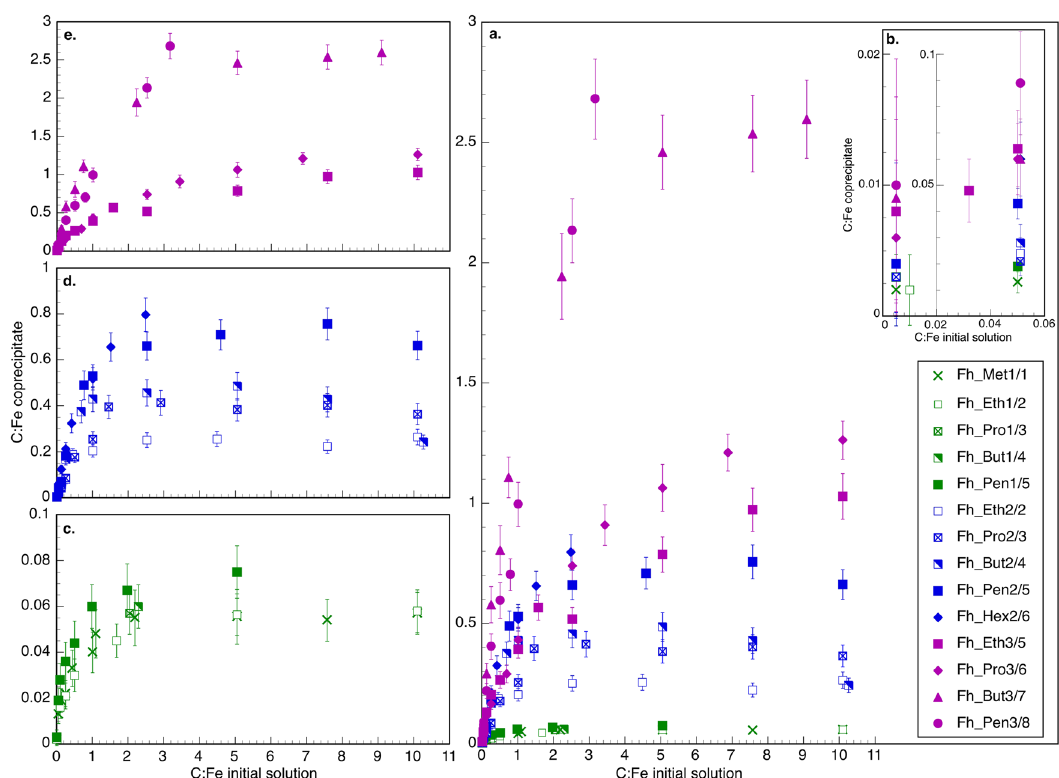
Fig. 2 Sequestration of mono-, di- and tri-carboxylic acids during coprecipitation with iron (oxyhydr)oxide ferrihydrite. Sequestration data for carboxylic acid ferrihydrite coprecipitates plotted as C:Fe molar ratio of initial coprecipitation solution vs. C:Fe molar ratio of resulting coprecipitate: a mono-, di- and tri-carboxylic coprecipitates for comparison, and b inset of mono-, di- and tri-carboxylic coprecipitates at low C:Fe initial solution; c mono- carboxylic coprecipitates; d di-carboxylic coprecipitates; e tri-carboxylic coprecipitates. Green, blue and purple colour codes depict mono-, di- and tri- carboxylic data, respectively. The coprecipitate nomenclature is given in Fig. 1. Symbols are as follows: cross: Fh_Met1/1; open square: Fh_Eth1/2 and Fh_Eth2/2; crossed open square: Fh_Pro1/3 and Fh_Pro2/3; half solid square: Fh_But1/4 and Fh_But2/4; solid square: Fh_Pen1/5, Fh_Pen2/5 and Fh_Eth3/ 5; solid diamond: Fh_Hex2/6 and Fh_Pro3/6; solid triangle: Fh_But3/7; solid circle: Fh_Pen3/8. Data points and error bars represent the mean and one standard error of the mean (1 SEM) for triplicate coprecipitates each measured in triplicate. Errors are propagated through all calculations using standard error propagation